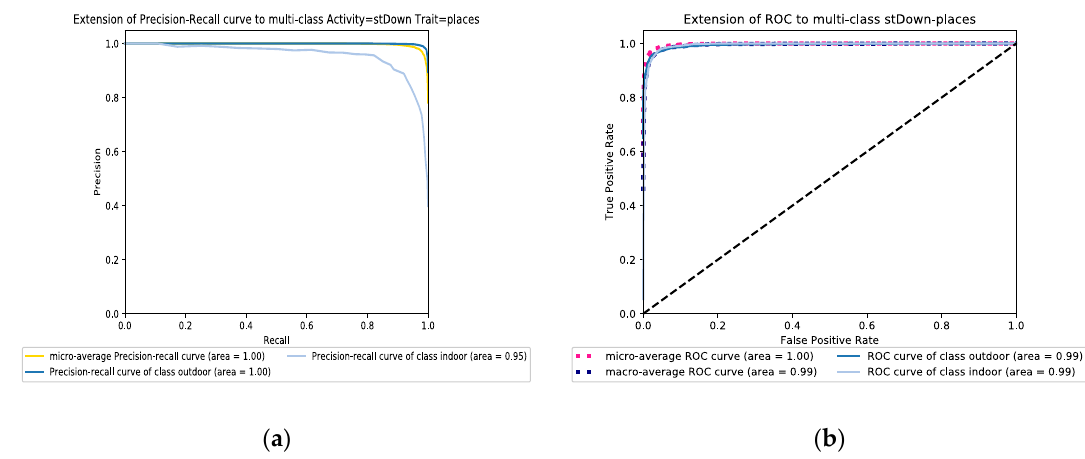
Figure 7. ( a ) The precision-recall graph and ( b ) the ROC graph of the Random Forest model in a balanced going down stairs dataset scenario. balanced going down stairs dataset